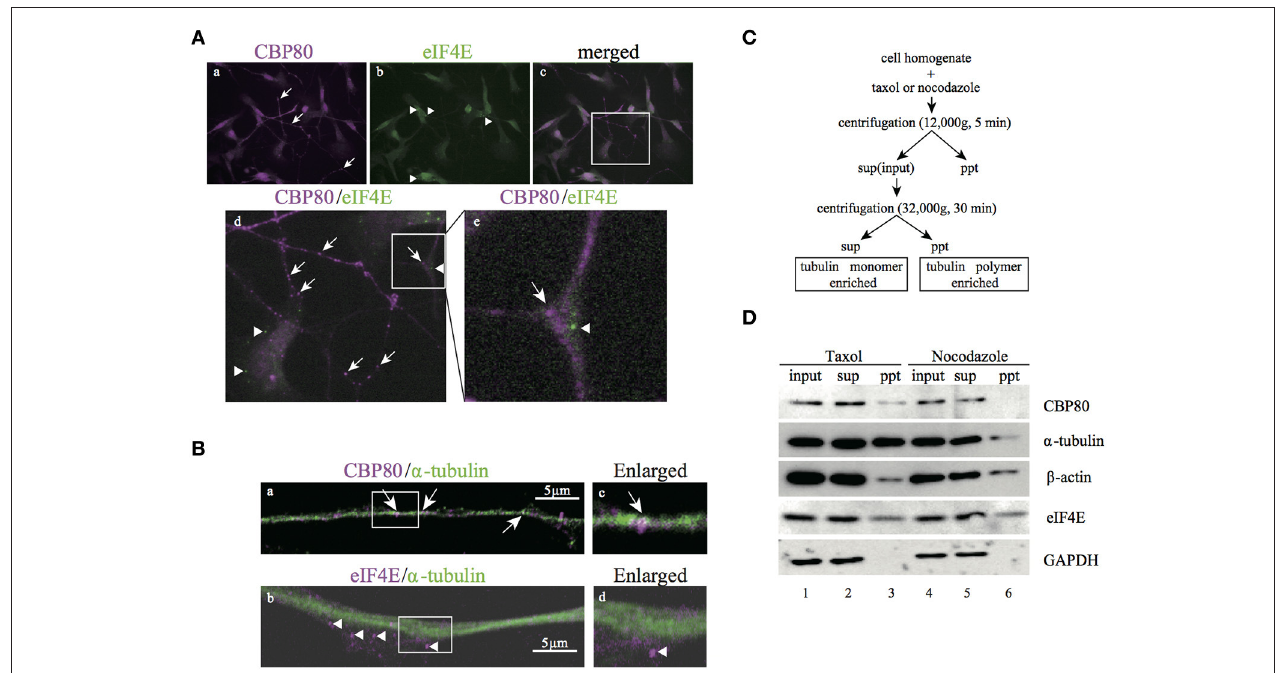
FIGURE 3 | CBP80-RNPs colocalize with microtubules and are spatially segregated from eIF4E-RNPs. (A) Microimages of differentiated SH-SY5Y cells co-stained with antibodies against CBP80 ( a , magenta), and eIF4E ( b , green). The Merged image is shown in (c) and the part in the white box enlarged in (d) or (e) , respectively. Arrows point to CBP80-positive puncta and arrowheads point to eIF4E-positive puncta. ( d,e ) Enlarged images in the white box. Arrow and arrowhead point to CBP80-positive punctum and eIF4E-positive punctum, respectively. (B) Confocal images of SH-SY5Y neuronal processes double-stained with CBP80 (magenta) (a) or eIF4E (magenta) (b) and α -tubulin (green) antibodies. The enlarged images of (a) and (b) are shown in (c) and (d) , respectively. White arrows point to CBP80-positive puncta and arrowheads point to eIF4E-positive puncta. Scale bars, 5 µ m. (C) The procedure of the biochemical fractionation assay for analysis of SH-SY5Y cells treated with taxol or nocodazole. sup: supernatant, ppt: precipitant. (D) Western blot analyses of CBP80, α -tubulin, β -actin, eIF4E, and GAPDH in different fractions.